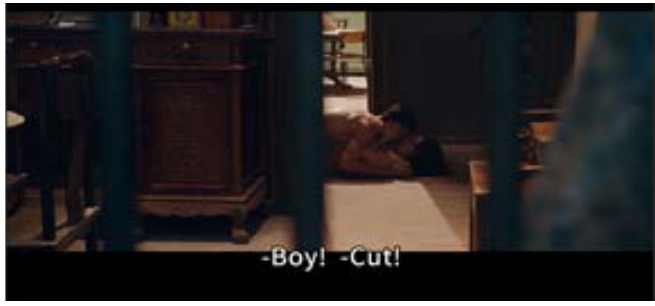
Fig.3: Director Sunny halting the scene of his mother being raped by her disabled son. Through this mise en abîme , that is the “relation of repetition and reflection the second-level narrative entertains with the quantitatively greater narrative within which it is contained” (Coste and Pier, par. early-1970s Penang, is a reconstruction of that Penang that serves as the set of the film within the film. presented as the characters of the childhood story (young Sunny, his mother and Ah Boy, his disabled brother) suddenly turn into actors playing actors in a movie. To further complicate the multi-layered filmic text, as in a game of mirrors, the film ends with a scene that overlaps memories and filmmaking in the opposite way: the man that the audience has seen as director Sunny until now enters the set to direct the